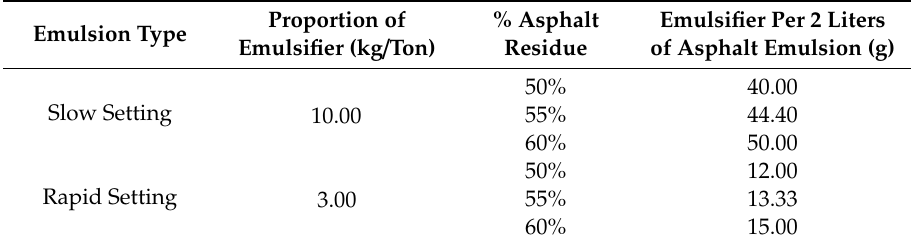
Table 1. Proportions of the emulsifiers.